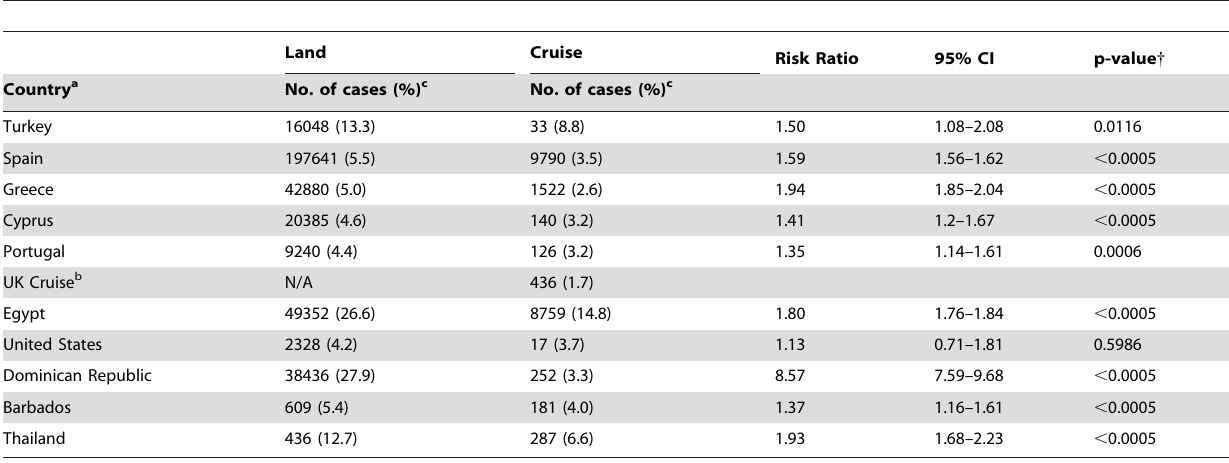
Table 3. Incidence of stomach upset on land- and cruise-based holidays to countries for which . 100 CSQs were received from cruise passengers.